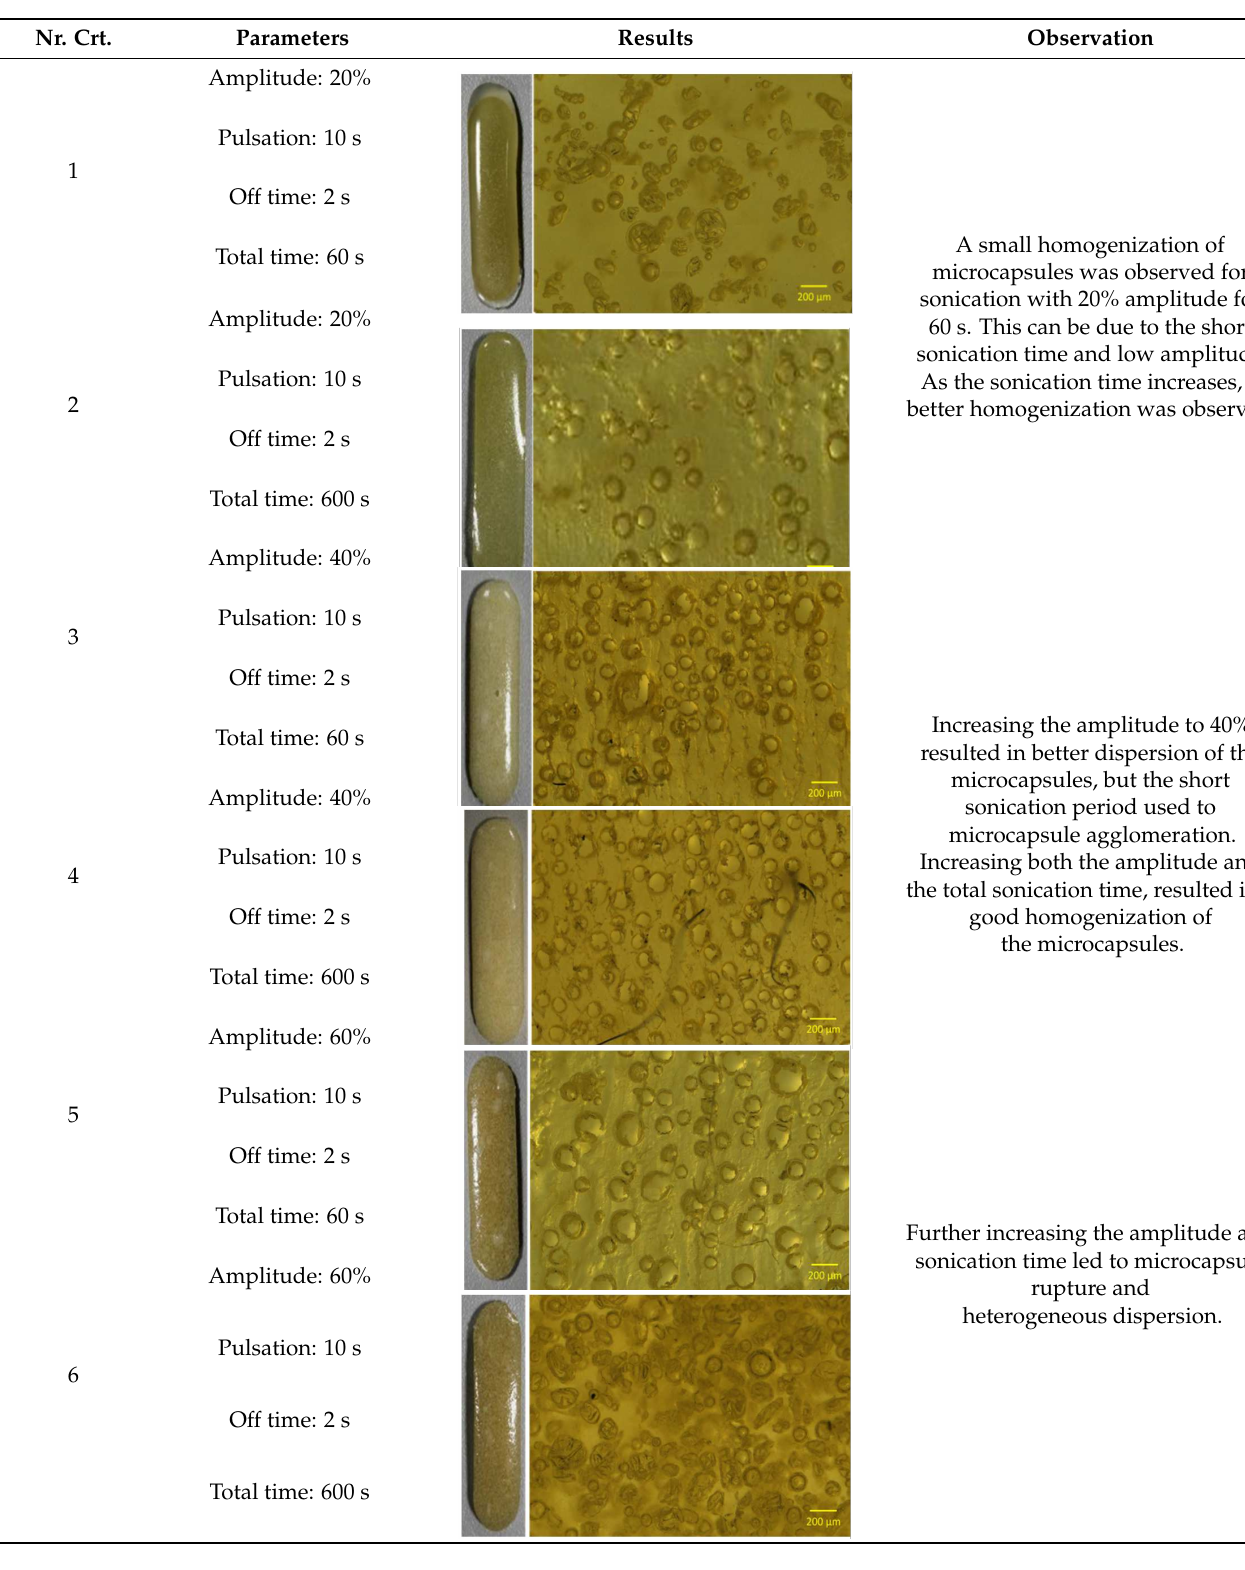
Table 3. Variation of sonication